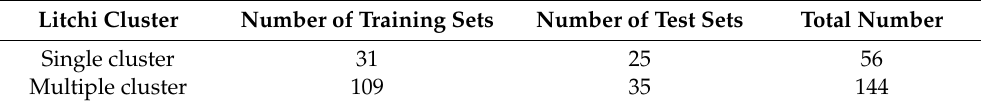
Table 1. Number of images in the dataset. Litchi Cluster Number of Training Sets Number of Test Sets Total Number Single cluster 31 25 56 Multiple cluster